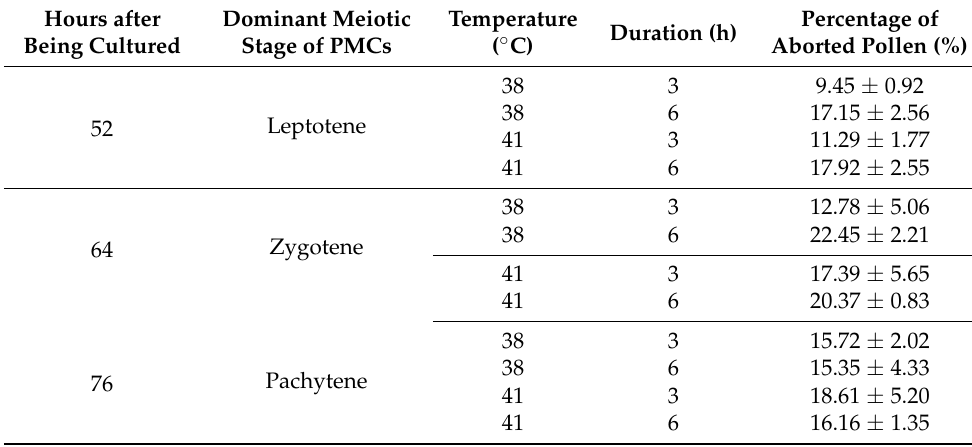
Figure 1. Aborted pollen and 2n pollen induced via high temperature exposure and spontaneously aborted pollen in P. canescens (scale bar = 20.0 μ m). ( a ) Aborted pollen (arrow) and high temperature-induced 2n pollen (arrowhead) in P. canescens . ( b ) Spontaneously aborted pollen (arrow) in P. canescens . Table 1. Aborted pollen production induced by high temperature in P. canescens.